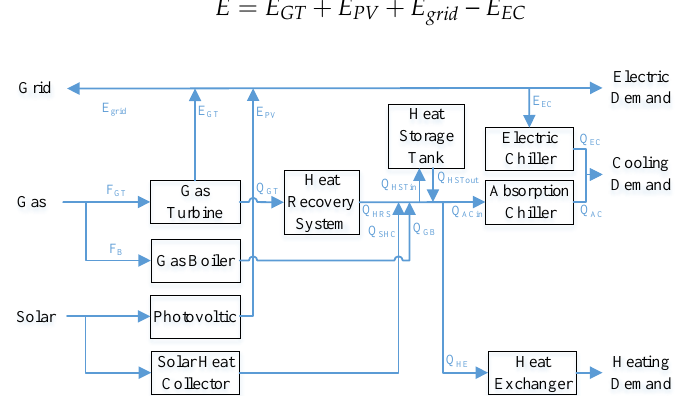
Figure 1. The hybrid combined cooling, heating, and power (CCHP) system configuration.